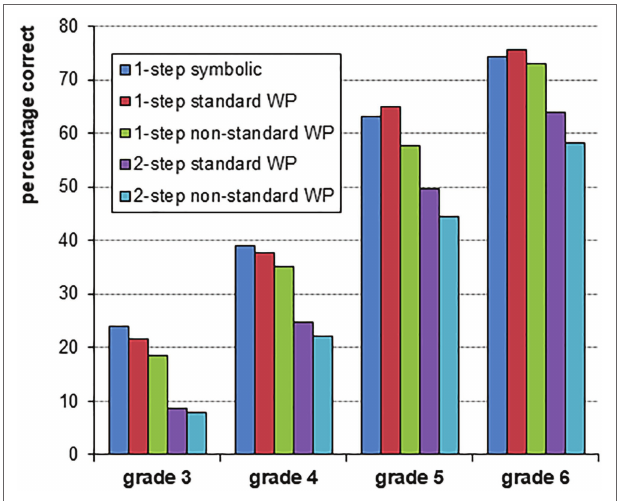
FIGURE 1 | Performance means on the five problem types by